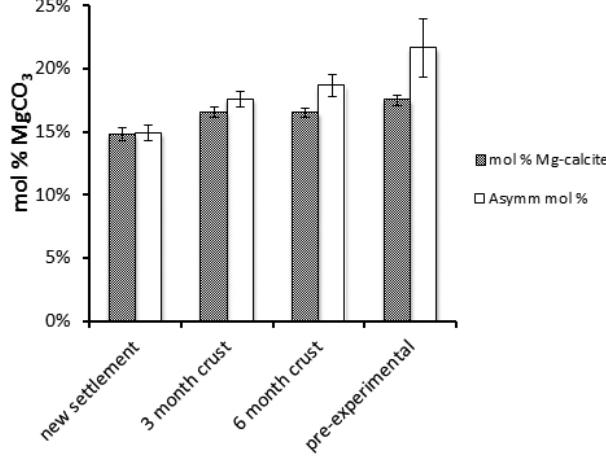
Figure 3. Magnesium composition for CCA new settlement, 3- month crust, 6-month crust, and pre-experimental crust. The mol% MgCO 3 in the Mg-calcite increases from new settlement to 3 and 6months, and again for the pre-experimental crust. Dolomite is not present in the new settlement, appears within 3months, increases in amount in the 6 month new crust, but is highest in the pre- experimental crust. Error bars are